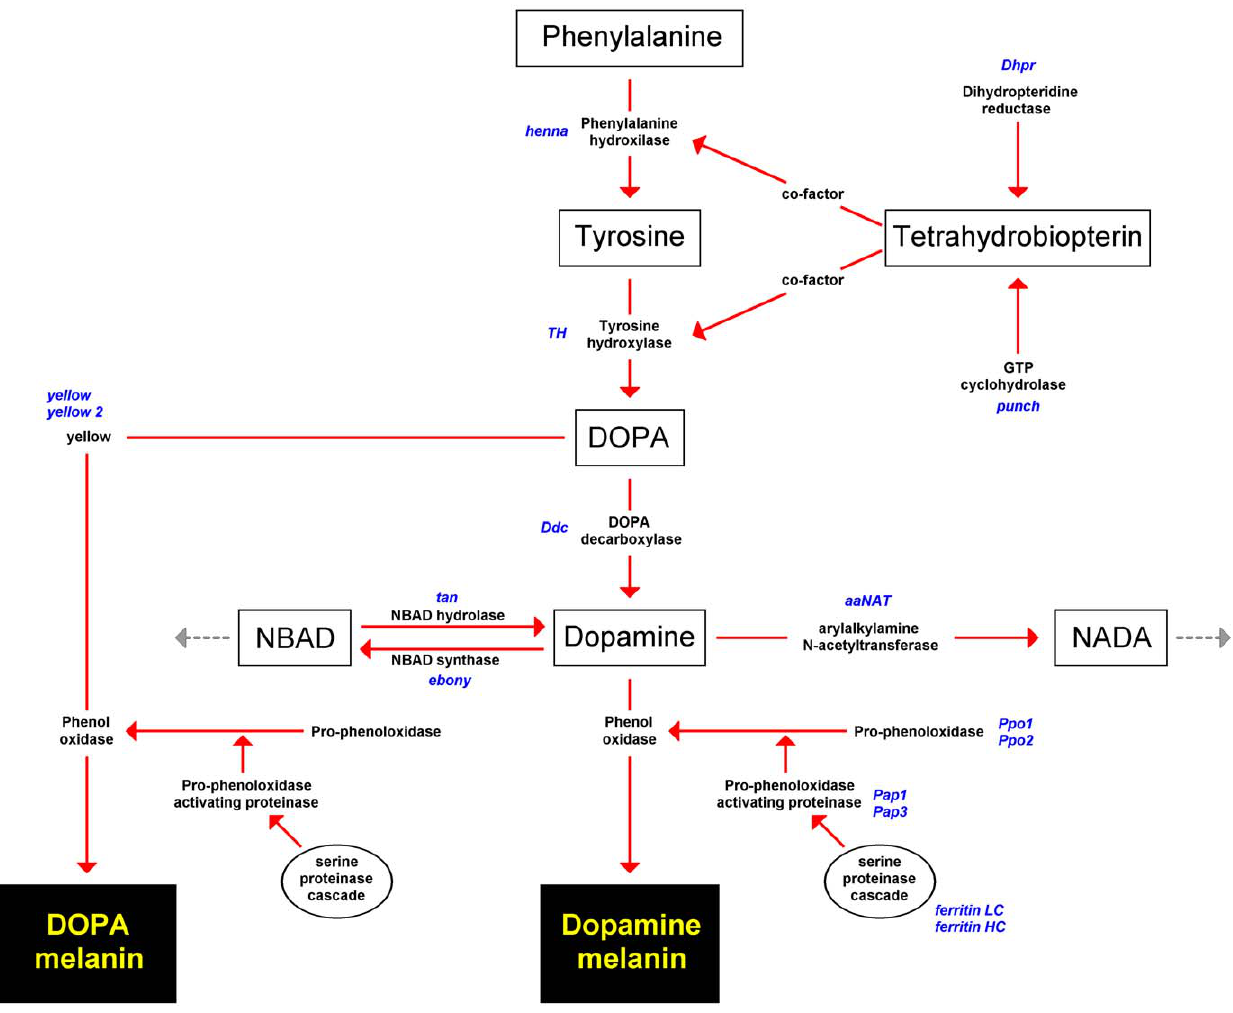
Figure 1. Insect melanisation biochemical pathway. The initial substrate, intermediate metabolites and two types of melanin are shown in rectangles. The enzymes that catalyze the different reactions are in black and the genes that code for these enzymes are italicized in blue. The genes in this figure correspond with the candidate genes that have been isolated and examined. The serine proteinase cascade is represented as a single cluster of events. A more comprehensive representation of this cascade is produced in Cerenius and So¨derha¨ll [8]. The interrupted arrows pointing away from NBAD and NADA indicate that these are not the final metabolites. (Figure adapted from De Gregorio et al. , True, and Futahashi & Fujiwara [16,17,20]).